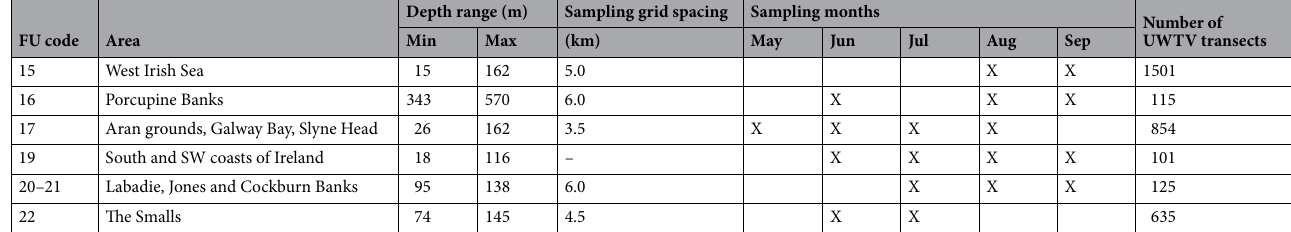
Table 1. List of Nephrops functional units (FU), including their code number, area name and depth range. FU grid spacing is shown for randomised isometric sampling designs. Random stratified sampling is used for FU19. The distribution of UWTV surveys across summer months and number of transects in each FU is also